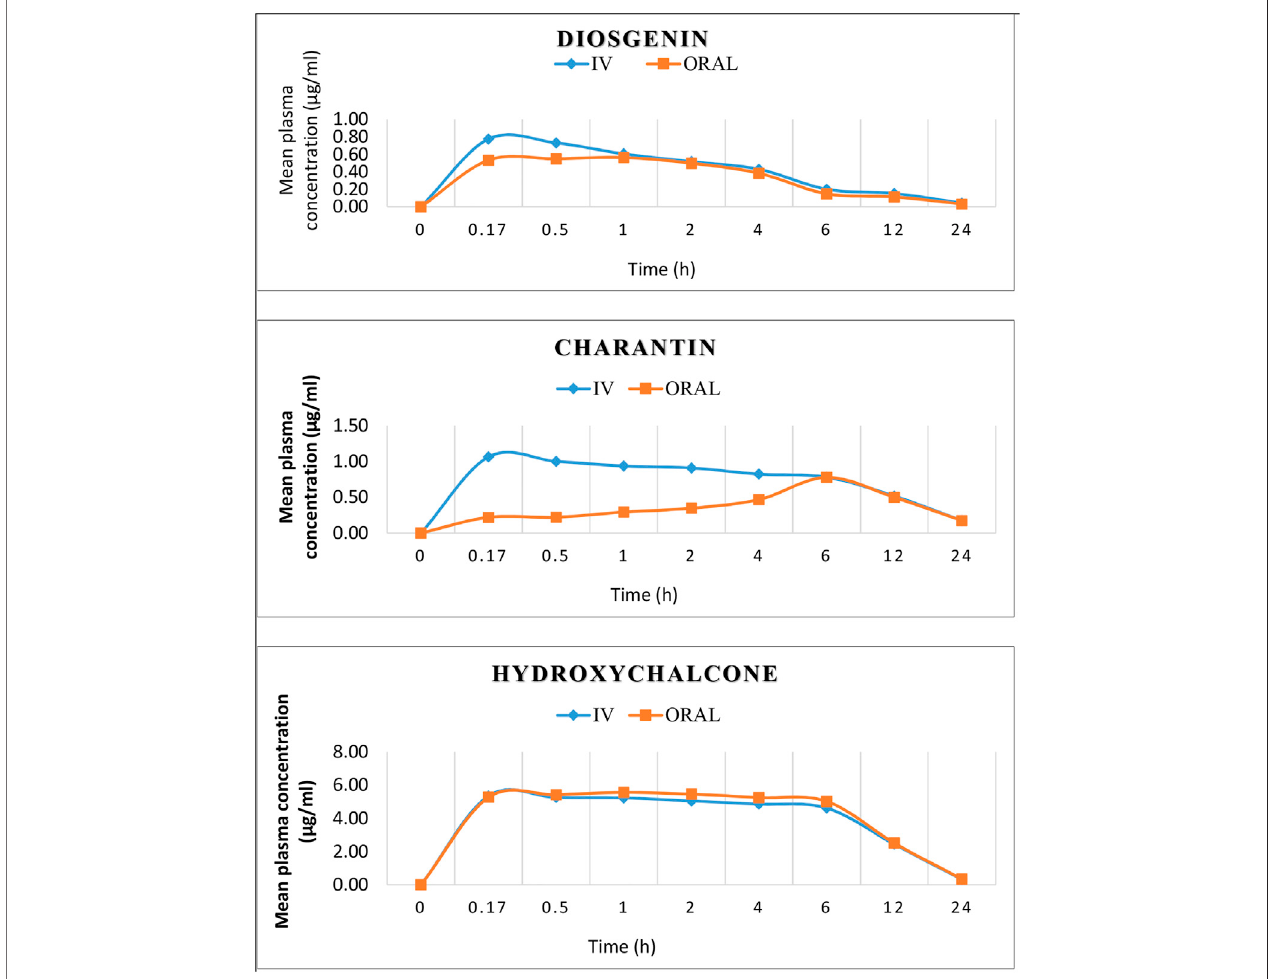
FIGURE 4 | Mean concentration – time pro fi les of diosgenin, charantin, and hydroxychalcone after i.v. (1.5 mg/kg) and oral (15 mg/kg) administration.